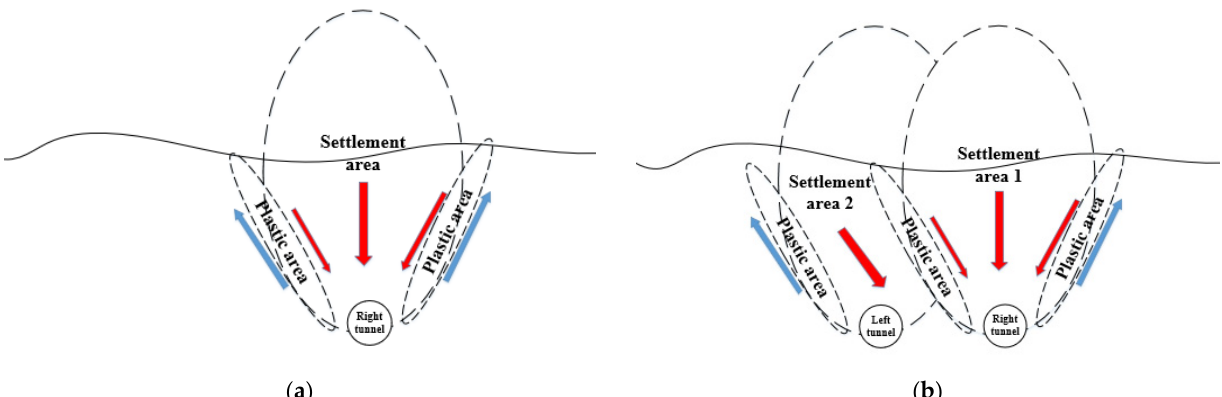
Figure 10. Distribution diagram of settlement area and plastic area. ( a ) Before the excavation of the left tunnel. ( b ) After the excavation of the left tunnel.